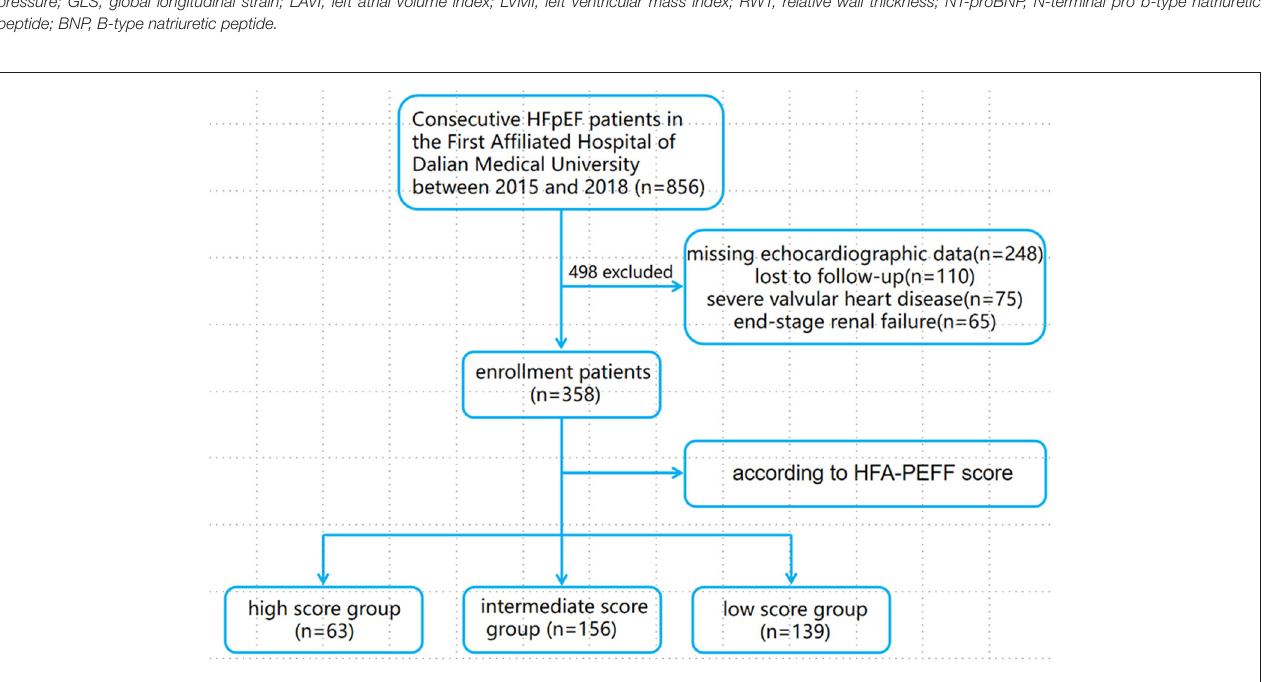
FIGURE 1 | Flowchart of the study